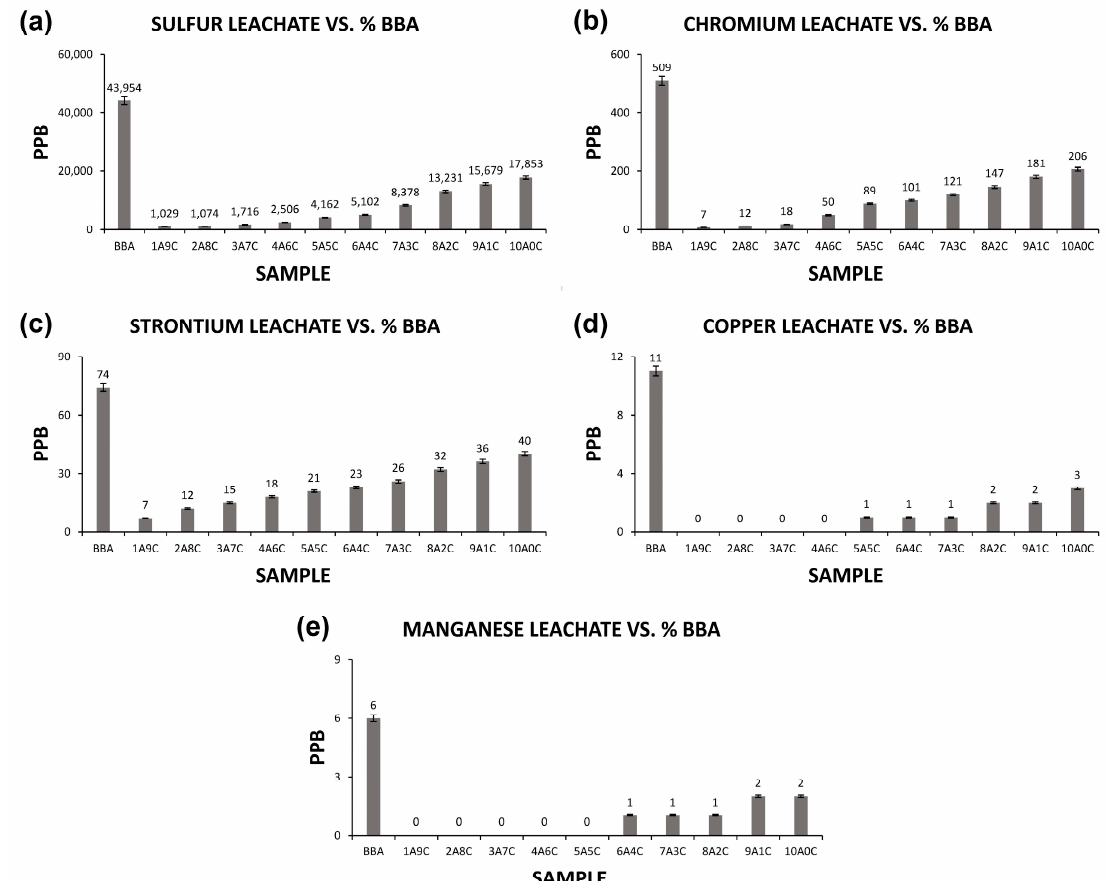
Figure 5. Graphs of the leachates of different chemical elements in the families of ceramic samples and in the unaltered sample of biomass bottom ash. ( a ) sulfur leachates, ( b ) chromium leachates, ( c ) strontium leachates, ( d ) copper leachates and ( e ) manganese leachates.